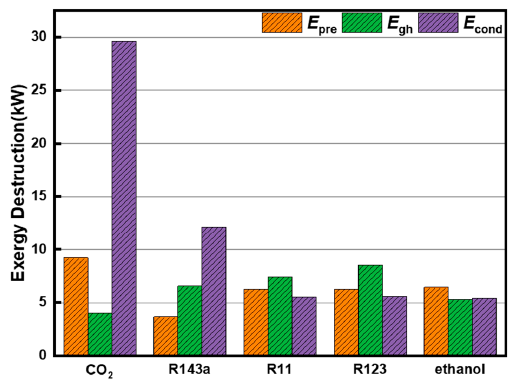
2 , ( b ) R143a, ( c ) R123, ( d ) R11, and ( e ) ethanol.